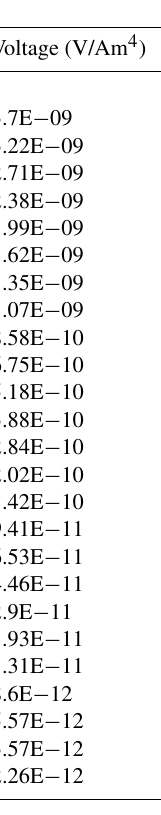
Table 2. Voltage response of the Selinunte sounding and the corre- sponding transformation into MIDI and frequency.